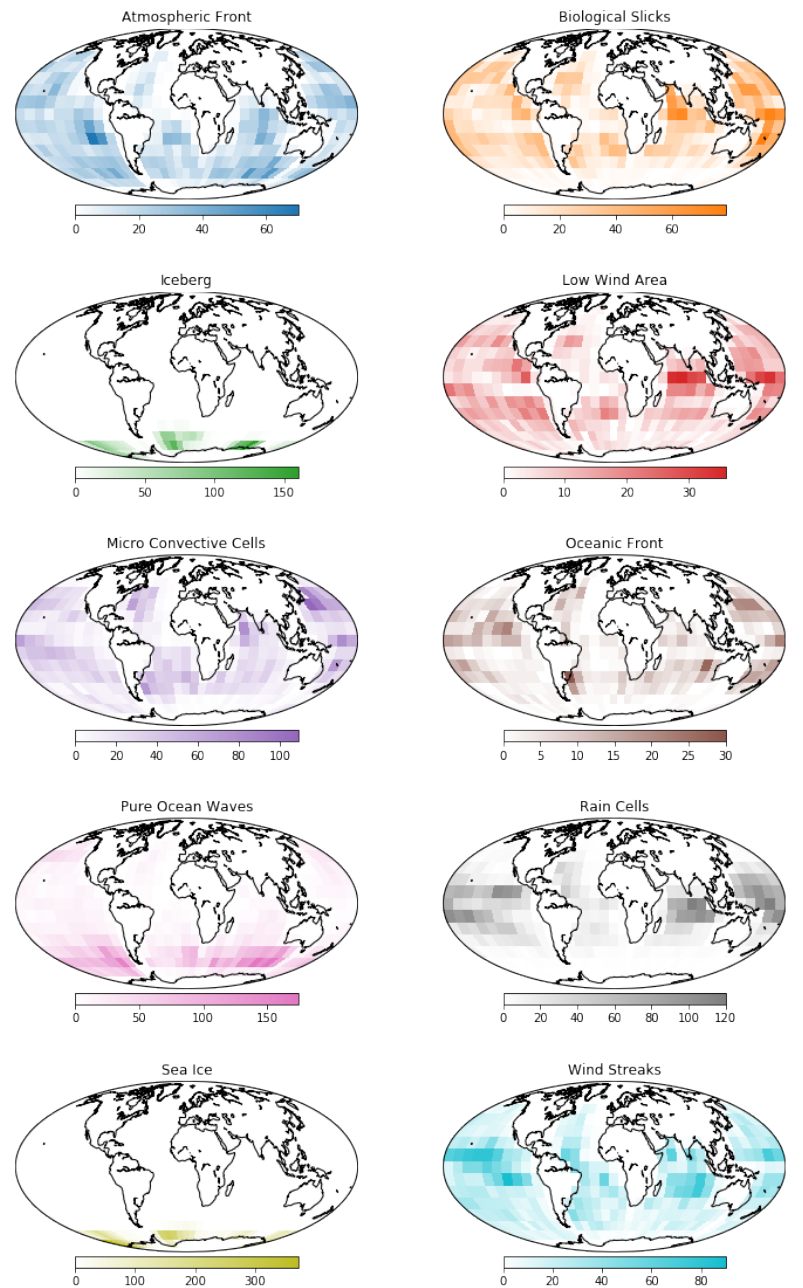
Figure 1. Number of TenGeoP-SARwv’s imagettes for each phenomena, projected on grid of 10° by 10°. These distributions are directly obtained from the groundtruth contained in